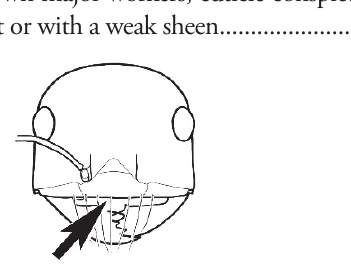
absent, check for long, appressed setae); head, mesosoma and gaster with relatively long, whitish, appressed setae that overlap and form a weak pubescence on the gaster in minor and known major workers; cuticle conspicuously shagreenate or